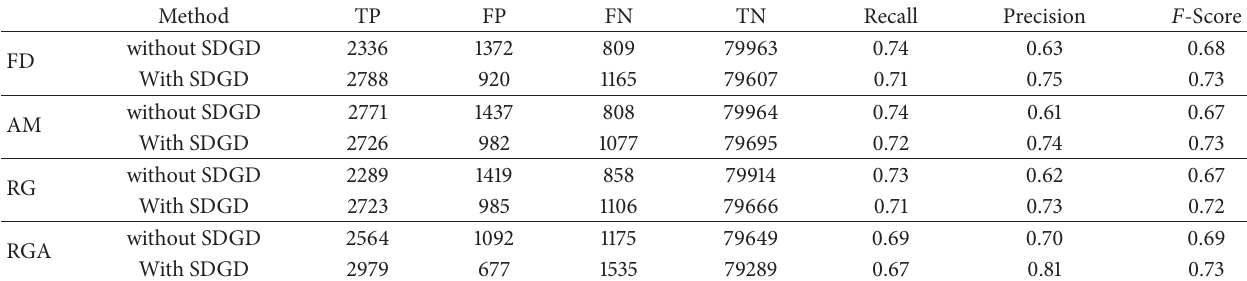
Table 2: Performance for frame 29 in indoor sample with and without SDGD